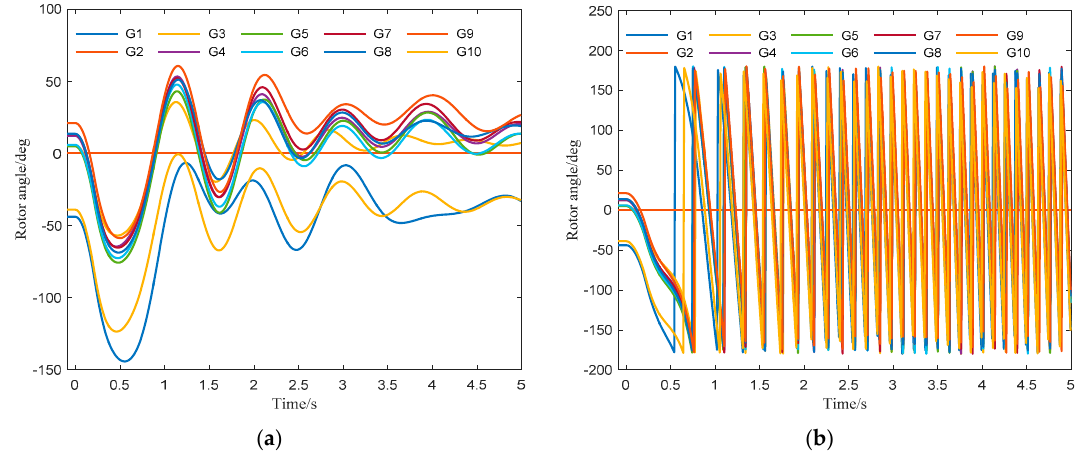
Figure 5. ( a ) Transient stable case; ( b ) transient unstable case.